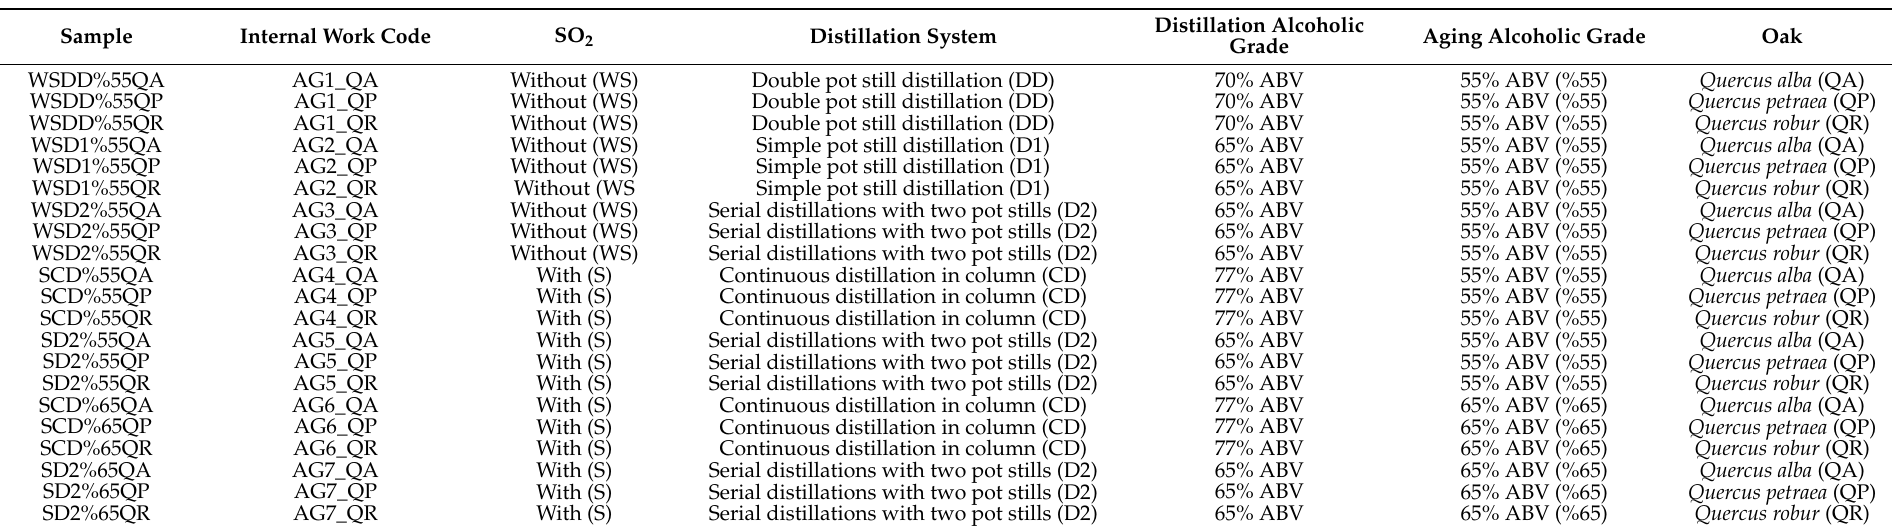
Table 1. Brandy-making trials included in this study. Each of these aging trials was conducted in light- and medium-toasted